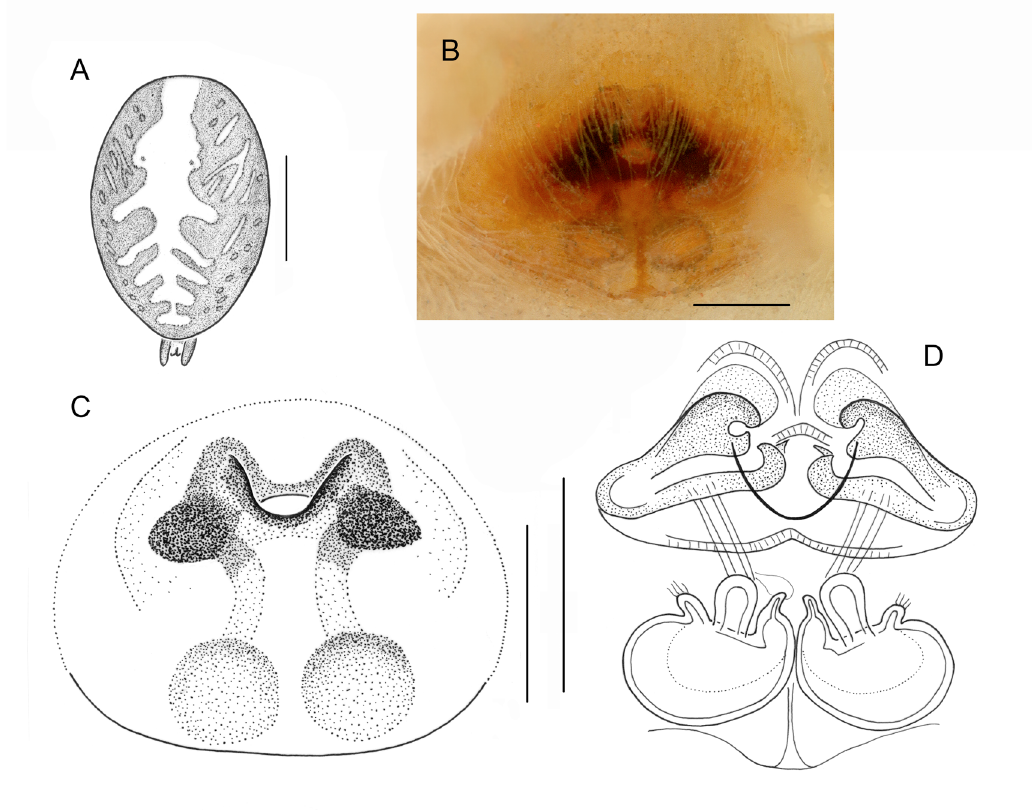
Fig. 8. Pochytoides perezi (Berland & Millot, 1941) comb. nov., holotype, ♀. A . Abdominal pattern. B – C . Epigyne. D . Internal structure of epigyne. scale bars: A = 1.0 mm, B–D = 0.2